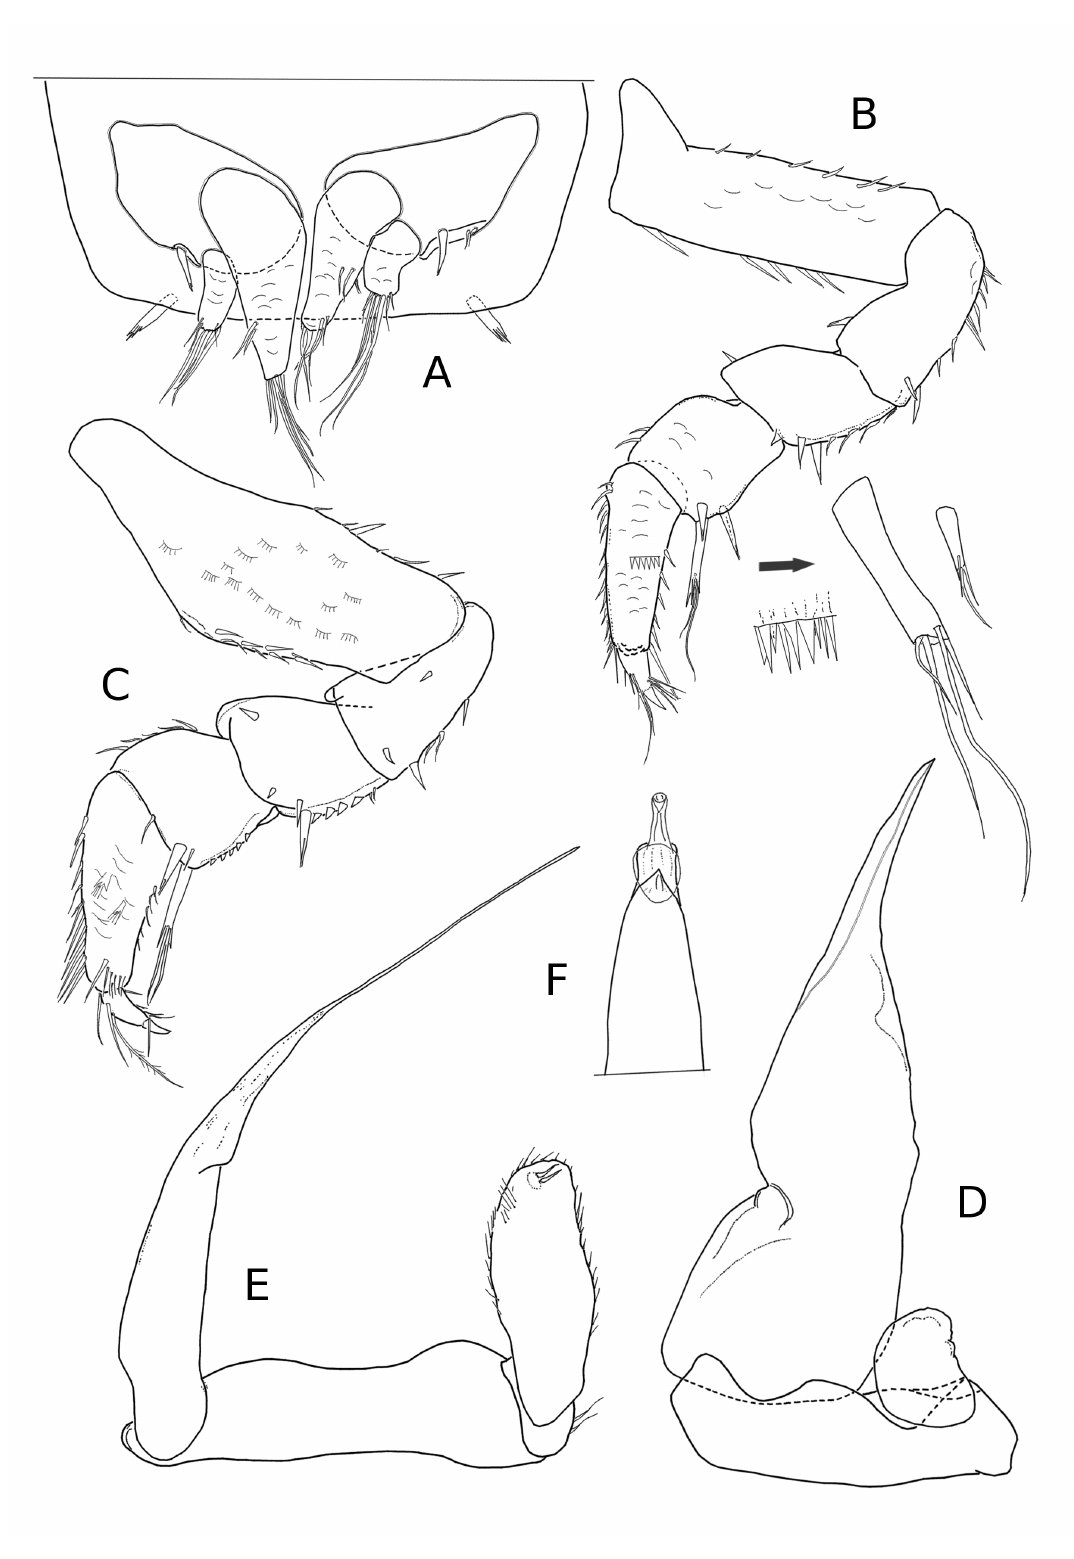
Fig. 6. Buchnerillo atlanticus sp. nov., paratype, ♂ (MBCN 24683). A . Pleotelson and uropods, ventral view. B . First pereopod; arrow indicates divided setae of carpus and pectinate scale of propodus. C . Seventh pereopod. D . First pleopod. E . Second pleopod. F . Genital papilla. Figure not to